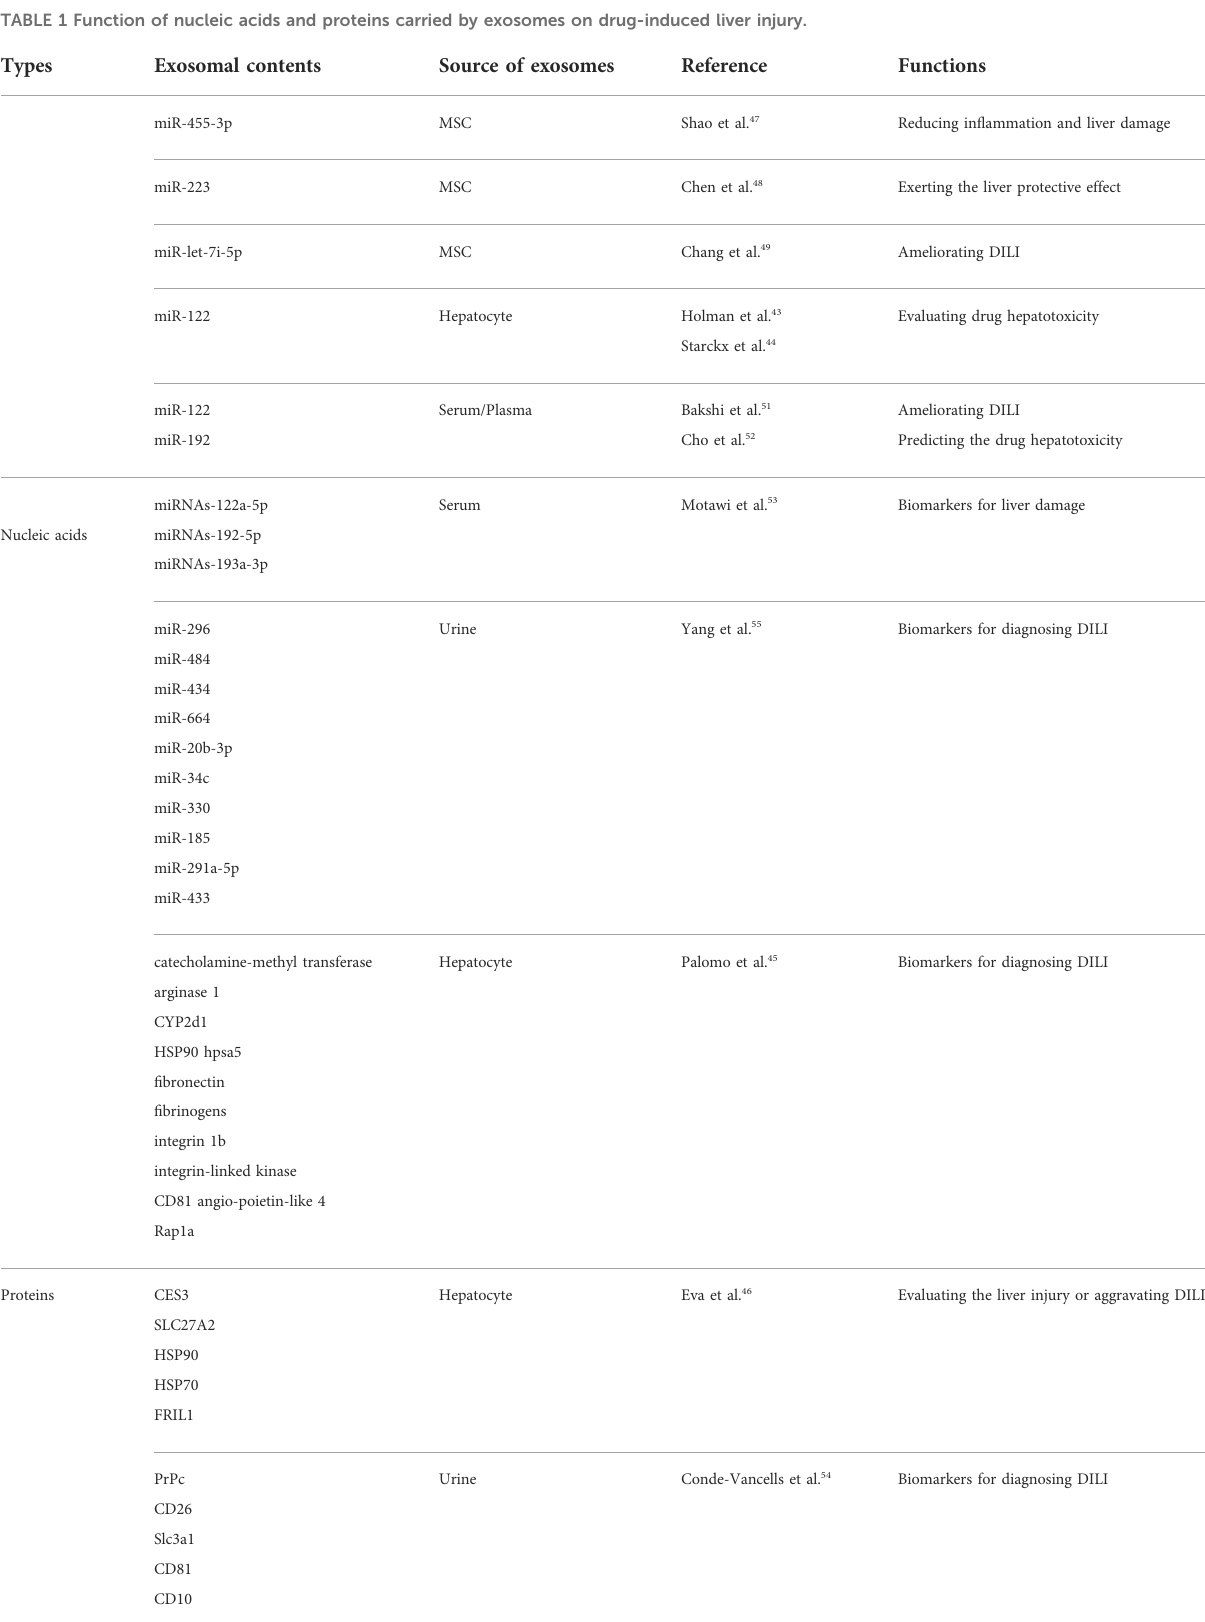
TABLE 1 Function of nucleic acids and proteins carried by exosomes on drug-induced liver injury.